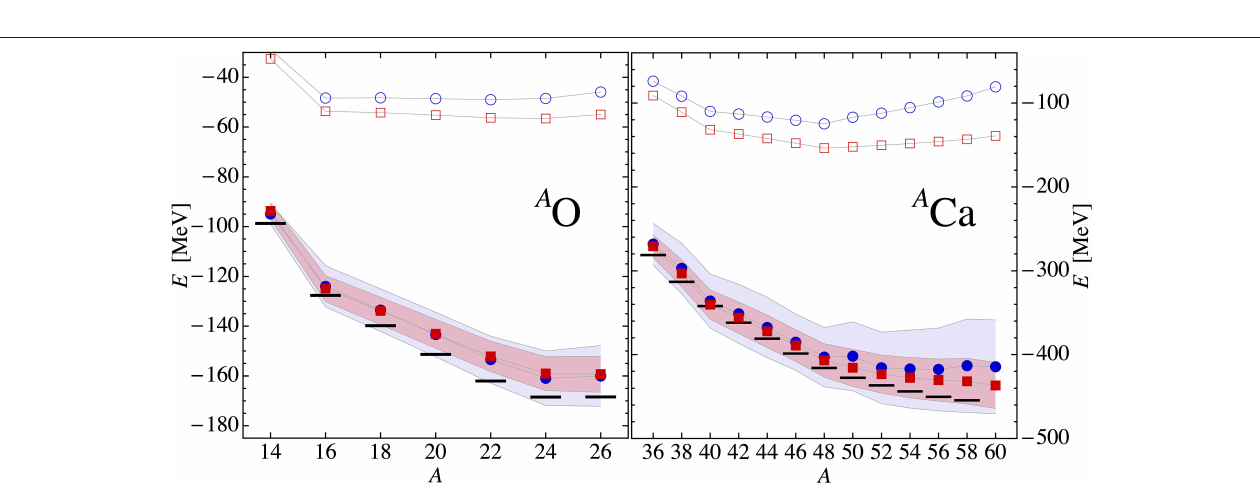
FIGURE 15 | BMBPT ground-state energies for oxygen and calcium isotopes at third order of the perturbative expansion using consistent non-local chiral two- plus three-nucleon interactions at N 2 LO (blue) and N 3 LO (red). Open symbols show the corresponding HFB ground-state energies. The uncertainty bands represent both, many-body and interaction uncertainties (see text). All calculations are performed using 15 oscillator shells and an oscillator frequency of ¯ h ω = 20MeV. The single-particle orbital angular-momentum quantum number was limited to l ≤